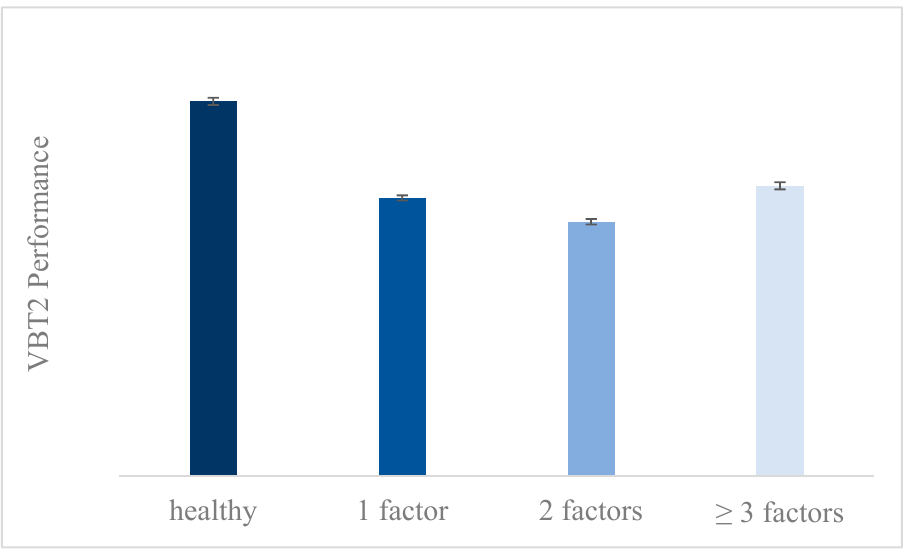
Figure 5. Participants’ performance in VBT2 according to their VRP.